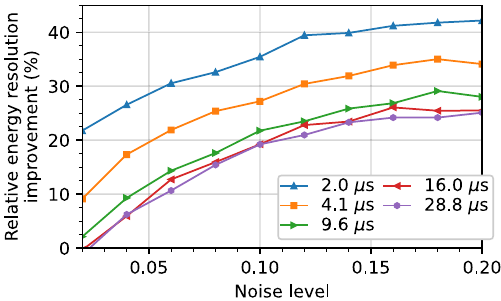
Fig. 7 Relative improvement in the energy resolution from denoising as a function of noise level on simulated pulses. Each curve